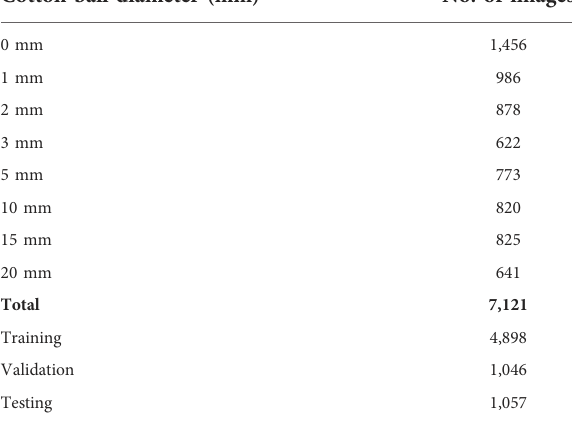
TABLE 1 Number of images acquired of each size cotton ball for training, validation, and testing of the model. Cotton ball diameter (mm)